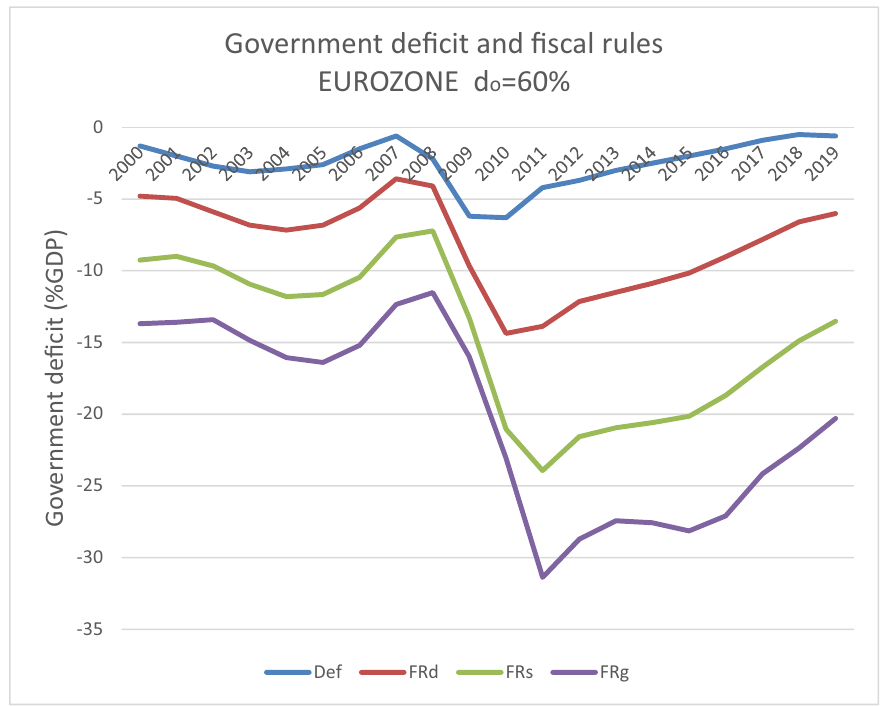
Figure 2.3: Eurozone countries government de fi cit ( Source: Own elaboration from data on Table 2 )